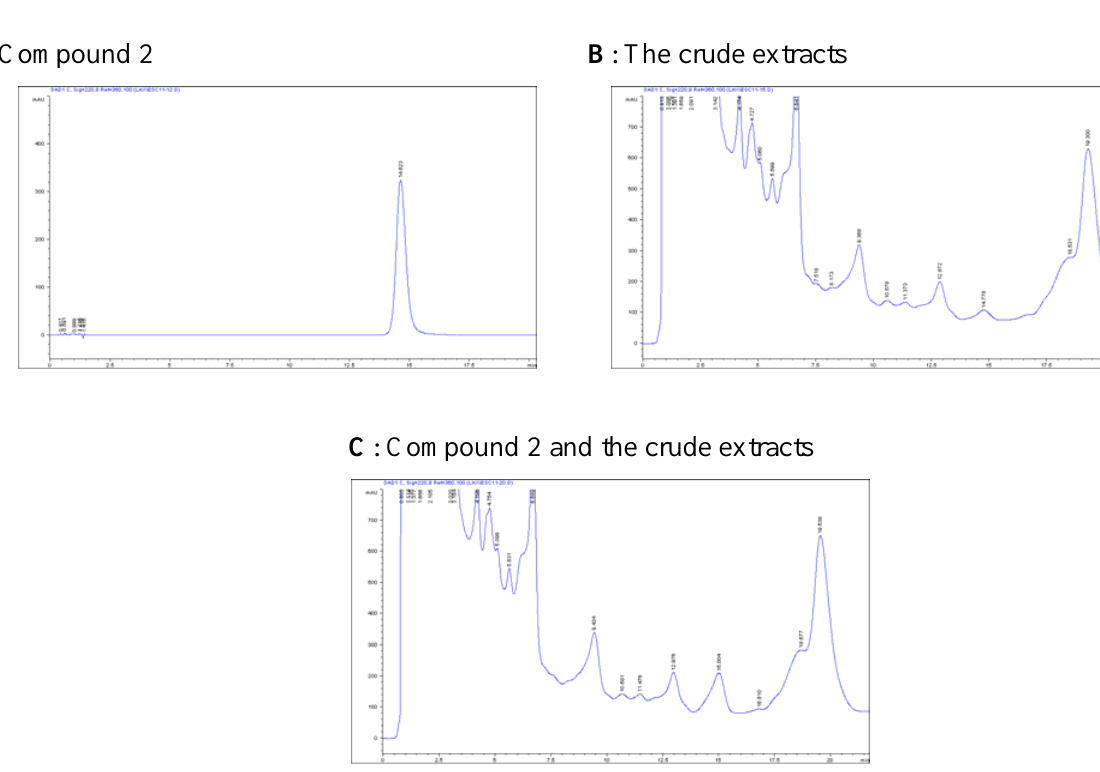
Figure 2. HPLC check of compound 2 in the plant